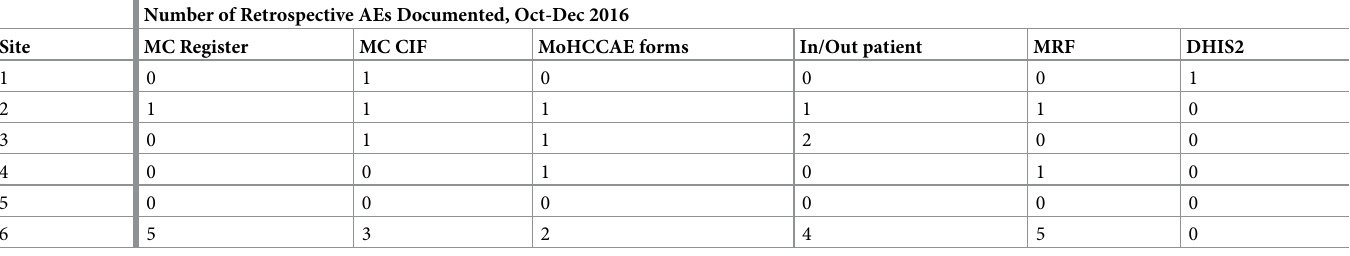
Table 2. Retrospective AEs found during AE form